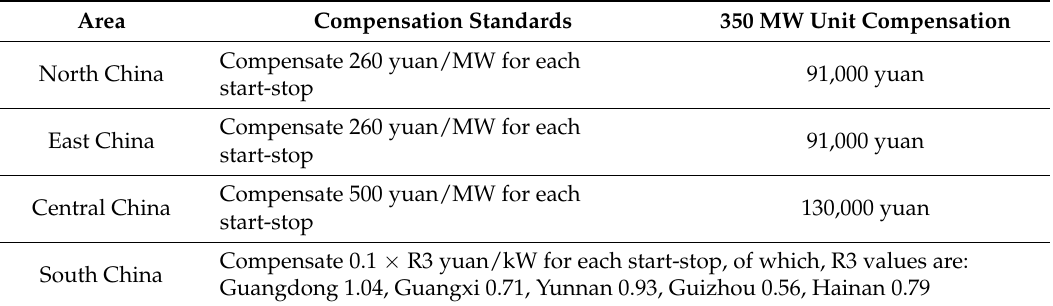
Table 10. Gas turbine peak